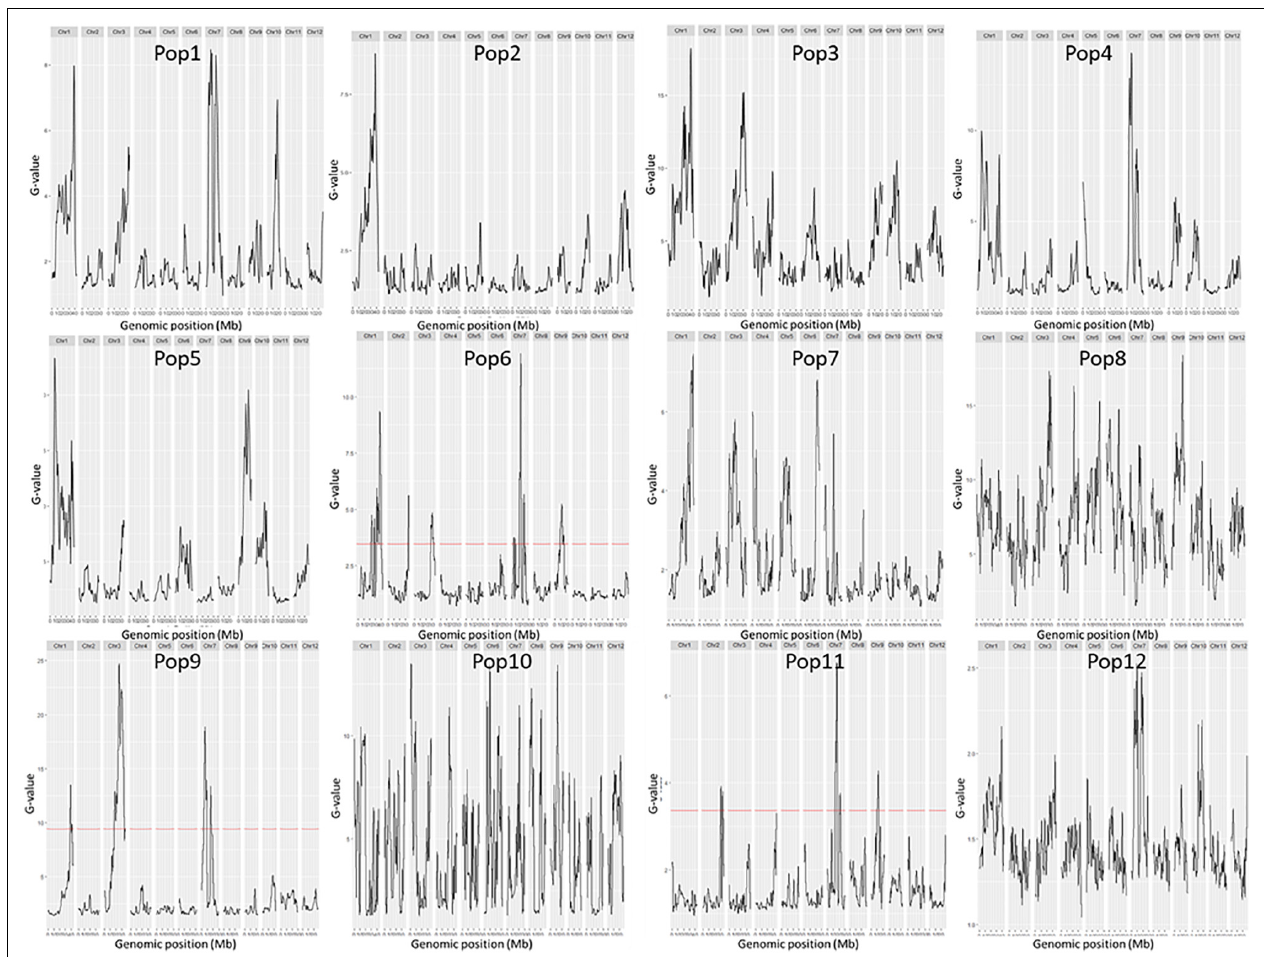
FIGURE 3 | G -values of the 12 F 2 populations. The female parents of the 12 F 2 populations were: 79 (Pop1), Bamla Suffaid 32 (Pop2), M 136–20 (Pop3), Cash (Pop4), Balam 2 (Pop5), Kalasu (Pop6), Black 28–573 (Pop7), Bhahuri Kalasu (Pop8), Changai Kalasu (Pop9), Basmati 385 Kalasu (Pop10), IR 64 Kalasu (Pop11), and BR 11 Kalasu